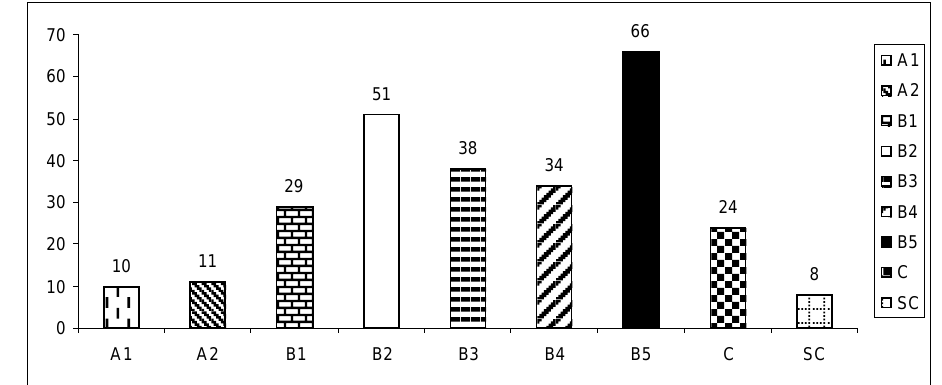
Figura 13. Total de publicações em periódicos nacionais e